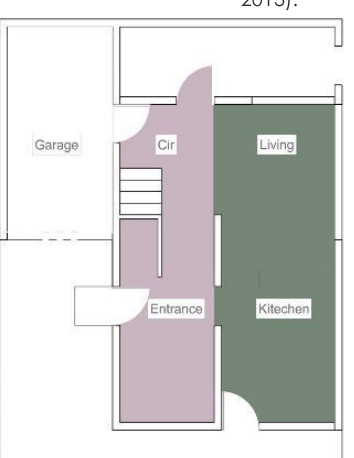
Figure 14. Efruz House Type 1 Open Plan (Esentepe, 2013).